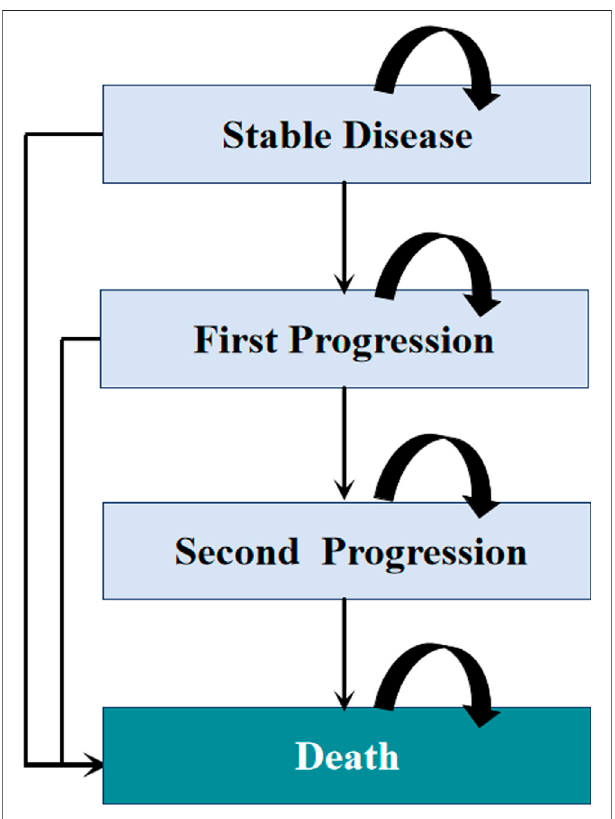
FIGURE 1 | Diagram of the Markov model. The percentage of patients receiving each line of subsequent therapy was de fi ned according to the CameL and KEYNOTE-189 clinical